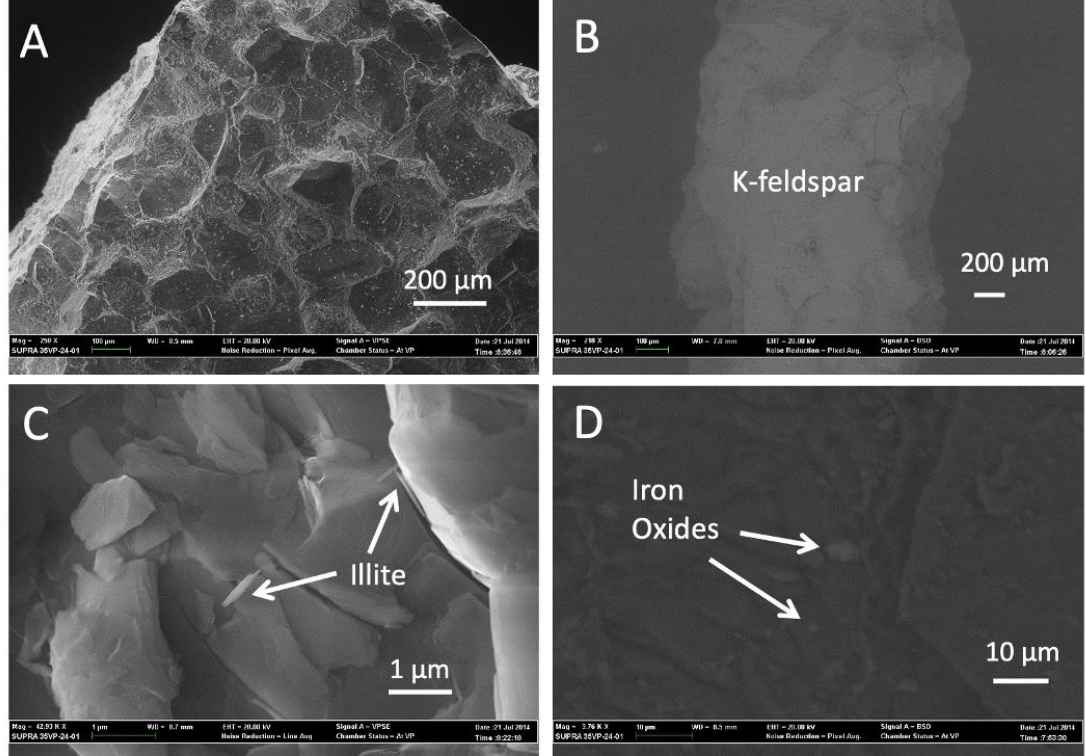
Figure 3. SEM images showing common textures and impurities are observed. ( A ) Low magnification image showing quartz grains and quartz cement as the pervasive texture. Grains are well- to sub-rounded and are approximately 100 to 300 µ m in diameter. Quartz comprises more than 95% of the cement and there is no visible porosity at this scale. ( B ) K-feldspar grains are uncommon and are sub angular with fractures. When observed, they are commonly 1 mm in maximum dimension. ( C ) SEM image of cement with abundant euhedral to subhedral illite particles < 1 illite µ m in diameter. This texture is predominant in samples. ( D ) Equant subhedral Fe-oxides 2 to 6 µ m in diameter embedded in quartz cement.